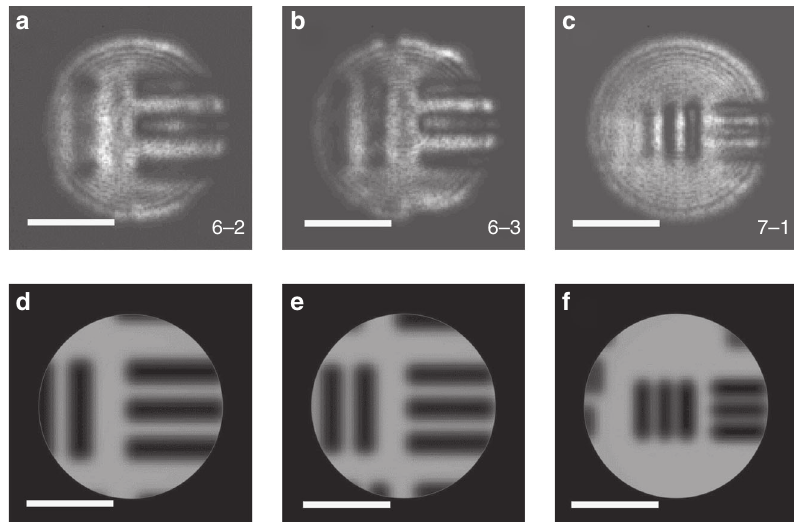
Fig. 6 Image testing results. a – c Optical images of USAF-1951 resolution targets collected using the aspheric meta-lens as a microscope objective: the numbers mark the group numbers of the bar target elements; d – f simulated images of the same groups of bar targets acquired by a hypothetical aberration-free imaging system otherwise identical to the experimental setup. The scale bars correspond to 30 μ